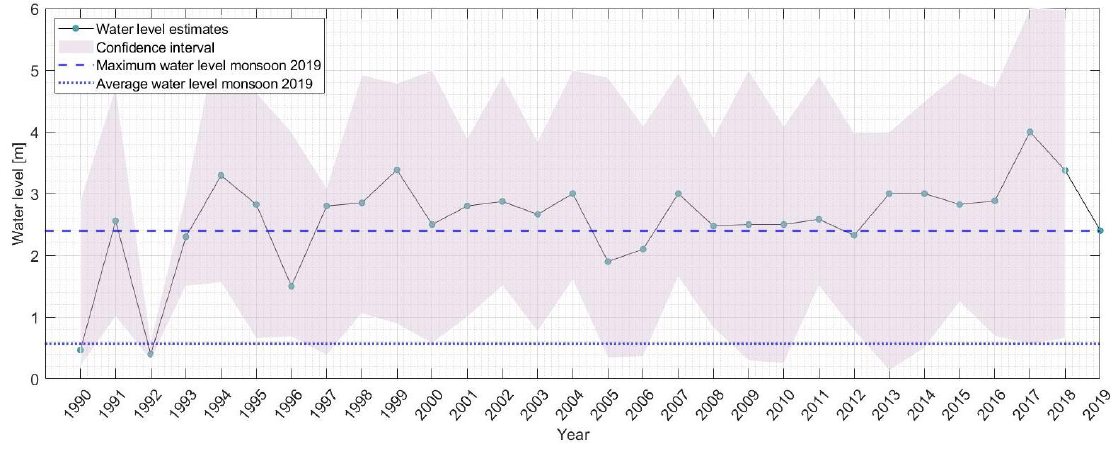
Figure 5. Maximum water levels obtained with SEJ for 1990–2019 (dots), with 5% and 95% quantile estimates (shaded). The maximum water level (striped line) and the average water level (dotted line) of the 2019 monsoon are also added to get an idea of the orders of